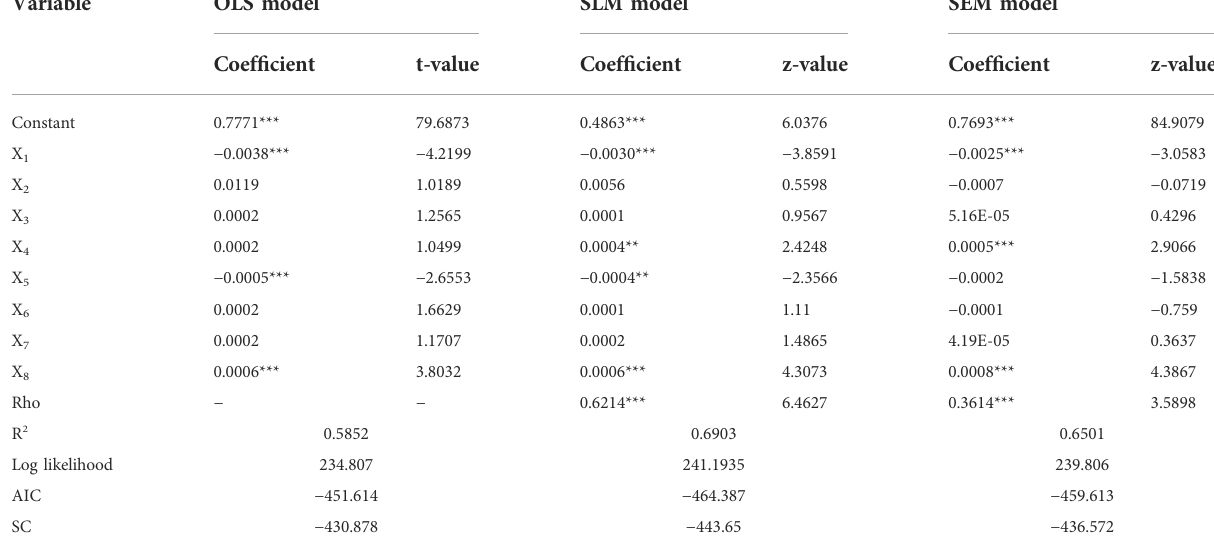
TABLE 5 Estimation results of spatial autocorrelation